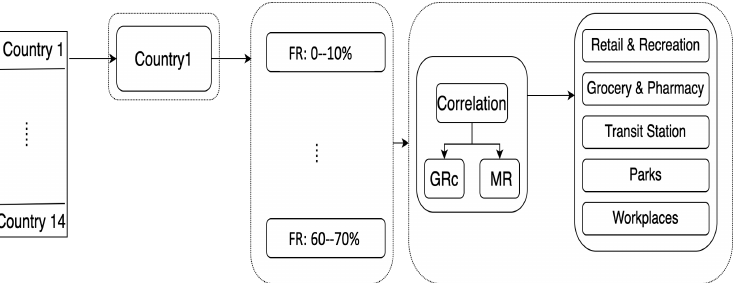
Figure 4. Flowchart showing the splitting of the fraction of resistance periods for each of the 14 countries and measuring the Pearson correlation between MR and GRc for all of the 5 POIs.